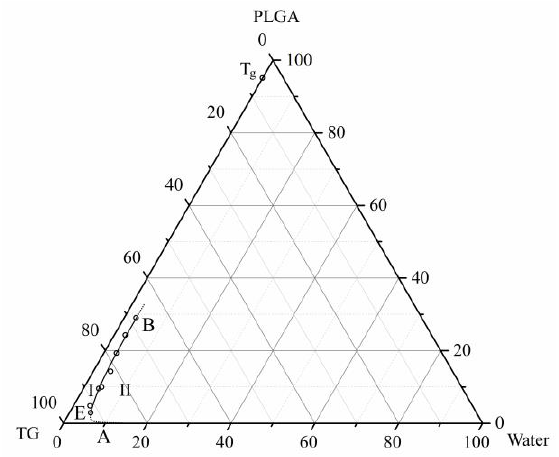
Figure 4. Ternary phase diagram for the PLGA/TG/water mixture at 25 ◦ C. The point T g plotted on the PLGA–TG axis corresponds to the mixture composition with which the polymer undergoes glass transition at 25 ◦